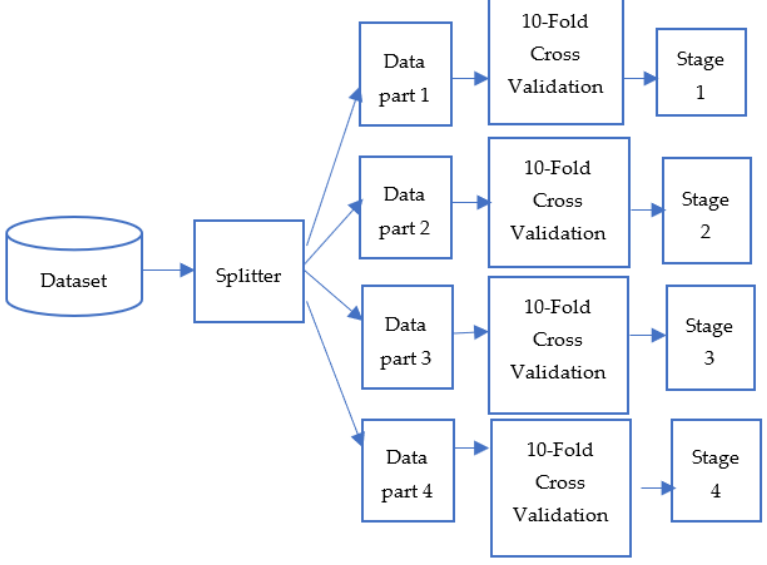
Figure 3. Architecture with optimization.